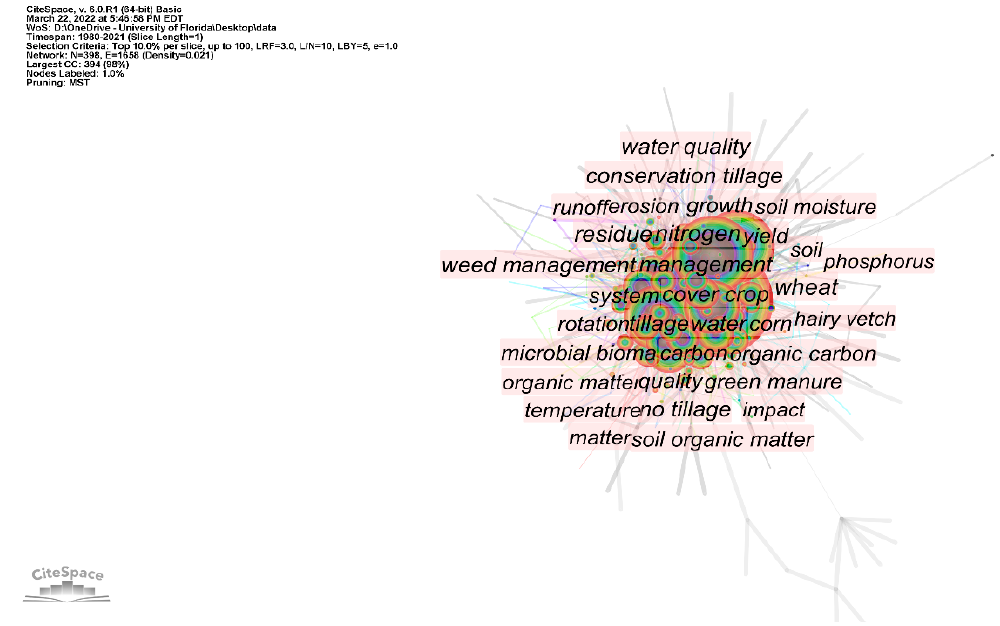
Figure 6. Co ‐ occurrence network of subject terms. Figure 6. Co-occurrence network of subject Table 6. Top five subject terms in co ‐ occurrence network by four indexes.